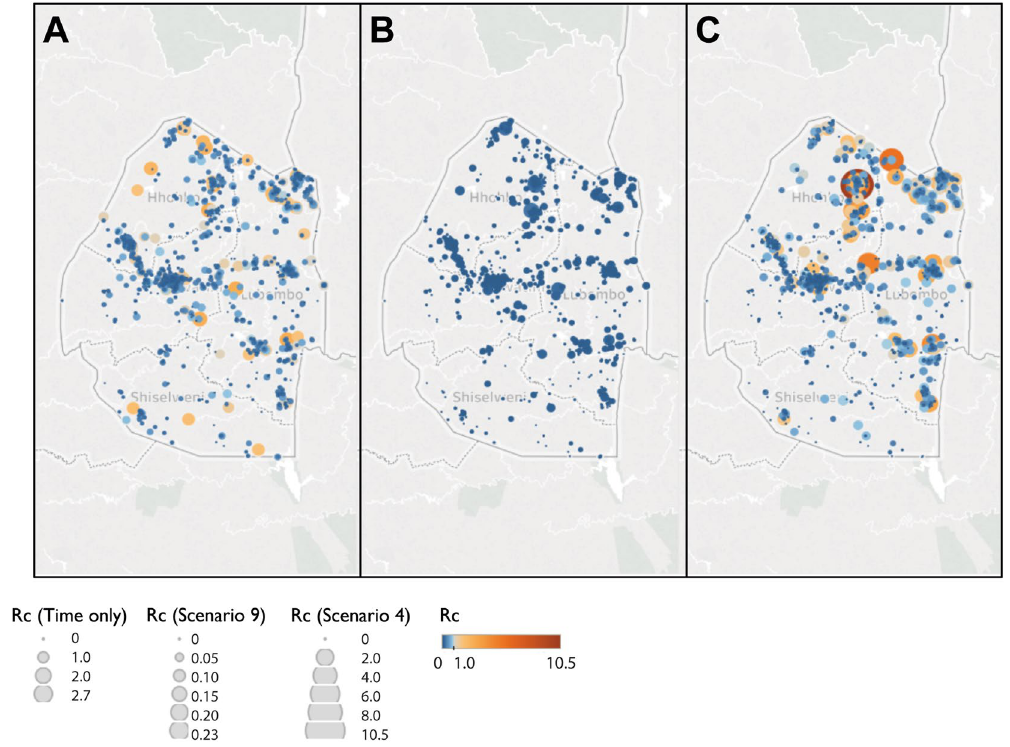
Figure 6. Map of Rc estimates for Eswatini Map of ( A ) time-only ( B ) best scenario by AIC (Scenario 9) and ( C ) Scenario 4, representing an assumption of little long-distance transmission and few unobserved cases. Note the increasing focality in ( C ), with higher Rc values estimated around the northern corner of the country which borders Mozambique.